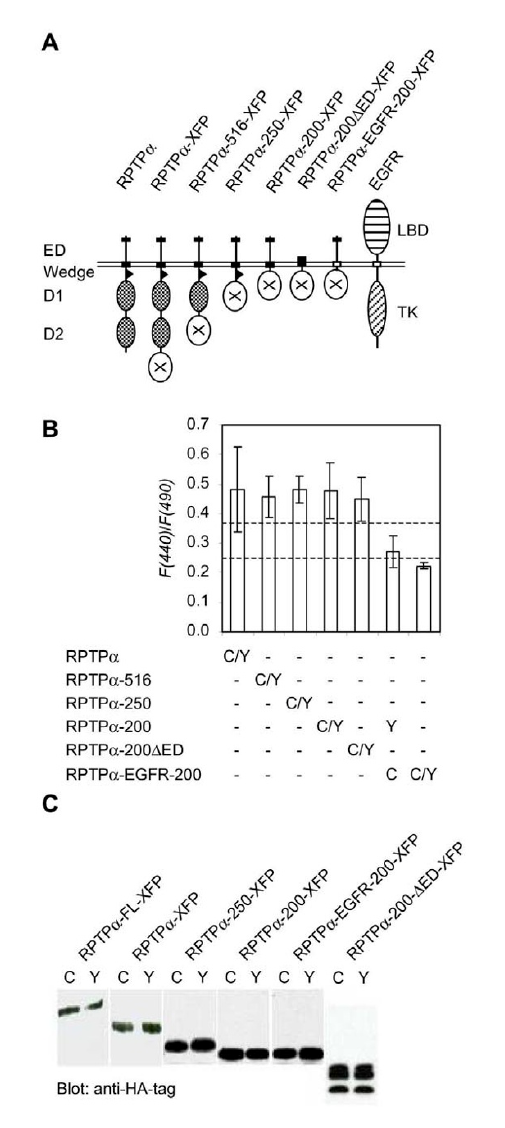
Figure 5 The transmembrane domain mediates RPTP α dimerization. ( A ) Schematic representation of RPTP α and deletion mutants. RPTP α fused to XFP (RPTP α -XFP) and deletion mutants lacking D2 (RPTP α -516-XFP), D1 and D2 (RPTP α -250-XFP), the entire cytoplasmic domain (RPTP α -200-XFP), or the cytoplasmic domain and the extracellular domain (RPTP α -200 ED-XFP) are depicted. RPTP α -EGFR-200-XFP is identical to RPTP α -200-XFP, except that the transmembrane and a short part of the intracellular domain were replaced by the corresponding regions of the human EGFR (depicted on the right). XFP (X) repre- sents either YFP or CFP. The RPTP α extracellular domain (ED) is indicated, as well as the transmembrane domain (RPTP α , black box; EGFR, open box), the wedge (triangle) and the two PTP domains (D1 and D2). The EGFR ligand binding domain (LBD) and tyrosine kinase (TK) domain are indicated on the right. ( B ) Deletion mutants of RPTP α , fused to CFP and YFP (depicted in A), were co-transfected as indicated, and F(440)/F(490) was determined in single living cells. Averages of at least 10 individual cells from at least two independent experiments are depicted with error bars indicating the standard deviation. The dashed lines indicate theoretical minimal F(440)/F(490) ratio (bottom dashed line), and the FRET threshold level (upper dashed line). According to a two-tailed student's t-test, all values except for RPTPalpha-200-YFP/ RPTPalpha-EGFR-200-CFP are signif- icantly different from the negative control, RPTPalpha-EGFR-200-CFP/ -YFP (p<0.003). ( C ) Expression of the constructs that were used in (B) was monitored by SDS-polyacrylamide gel electrophoresis using different gels (7.5 - 12.5%, depending on the size of the construct), and immunoblotting, using an anti-HA-tag antibody as a probe, to verify that CFP and YFP were expressed at similar levels. The molecular weights of the fusion proteins are: RPTP α -XFP, 160 kDa; RPTP α -516-XFP, 130